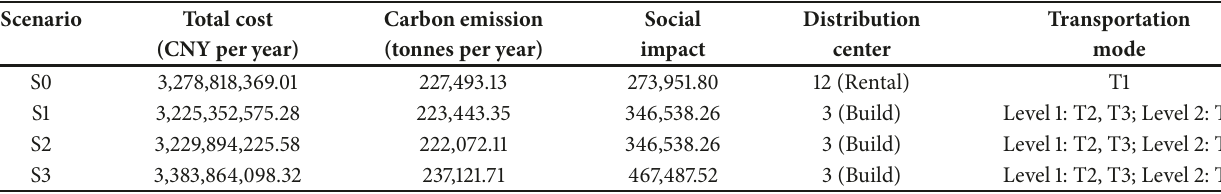
Table 6: Current model and the optimal solutions under three dimensions (T1: road; T2: rail; T3: